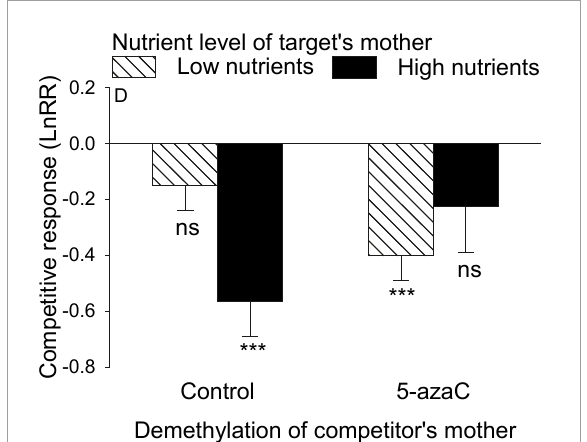
FIGURE4 The interactive effect between DNA demethylation of the competitor’s mother and the nutrient level of the target’s mother on the competitive response of the target plant of Pistia stratiotes . Bars show means + SE. Symbols (*** P < 0.001) indicate significant difference from zero (by one-sample t -test).